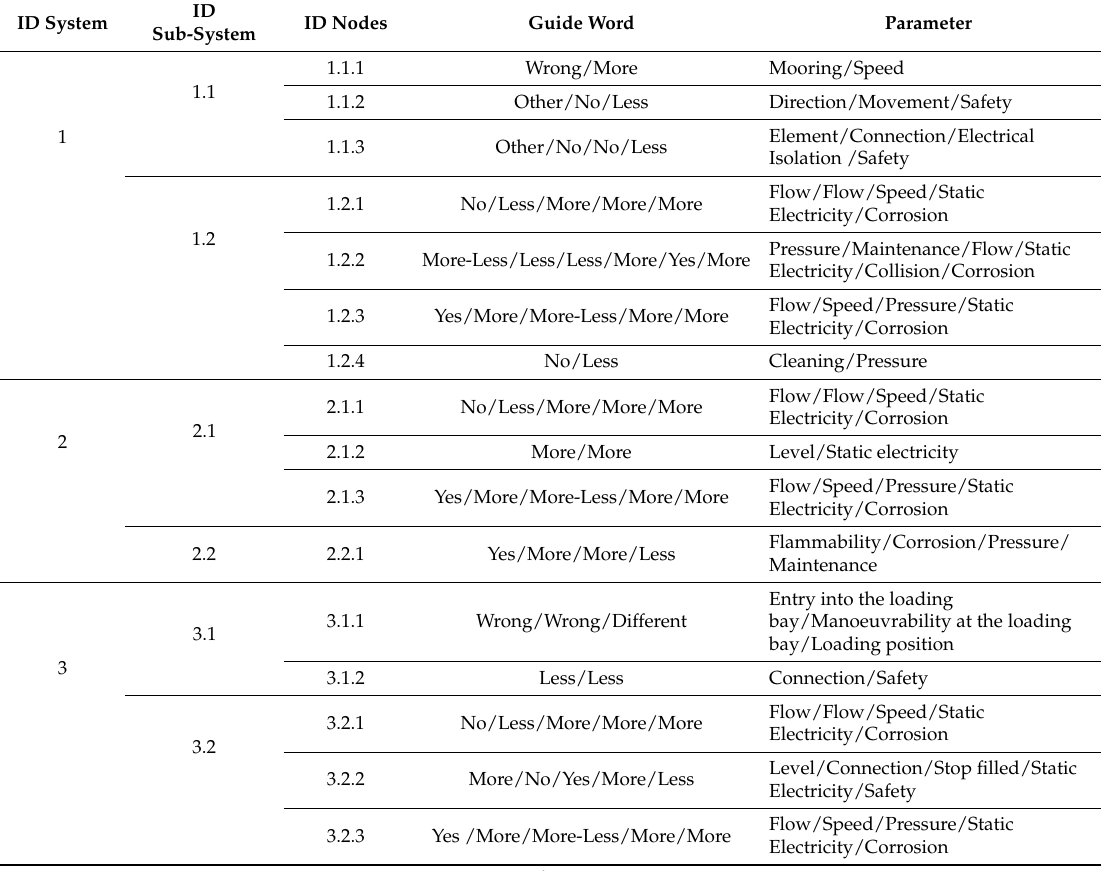
Table 4. Guide Words and Parameters used in the HAZOP